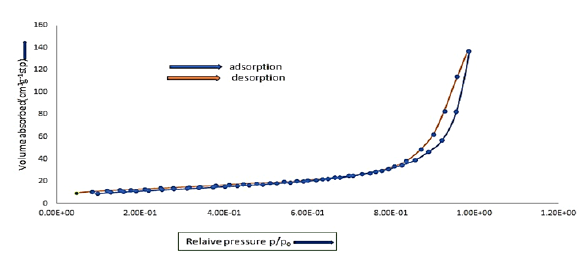
Figure 4. N 2 gas adsorption-desorption isotherm for magnetic ironoxide nanoparticle